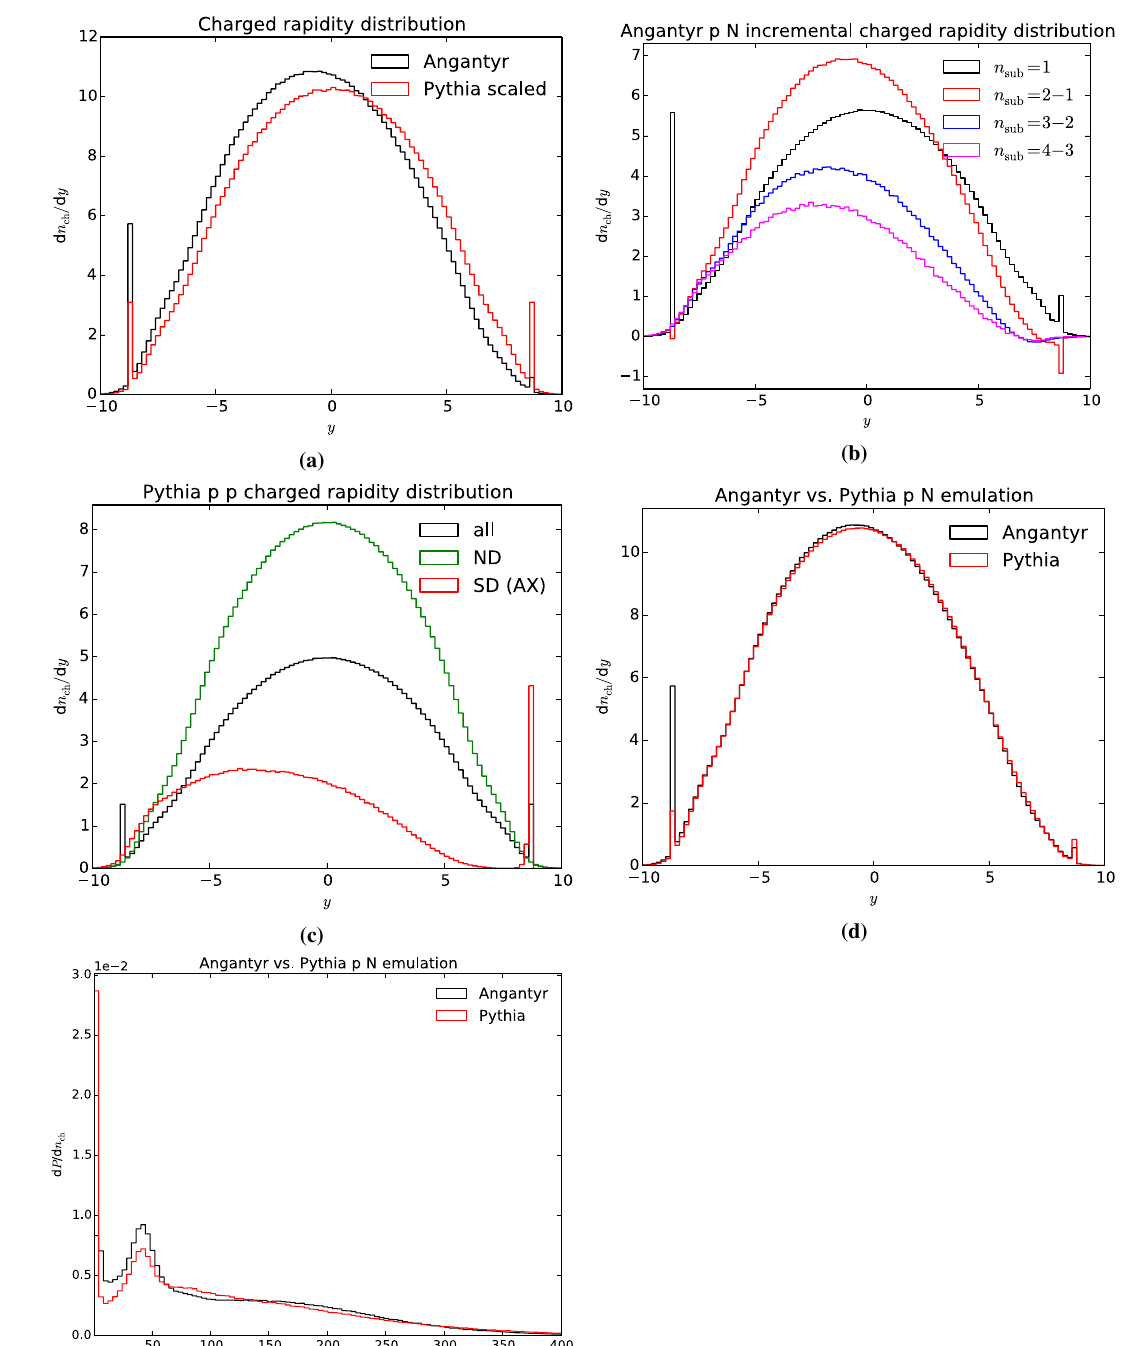
Fig. 10 Charged rapidity distributions d n ch / d y for a nucleon–nucleon collision energy of 6 TeV. a Inclusive Angantyr pN events relative to Pythia events scaled up with the average number of subcollisions in Angantyr . b Angantyr fordifferentnumberofsubcollisions,relative